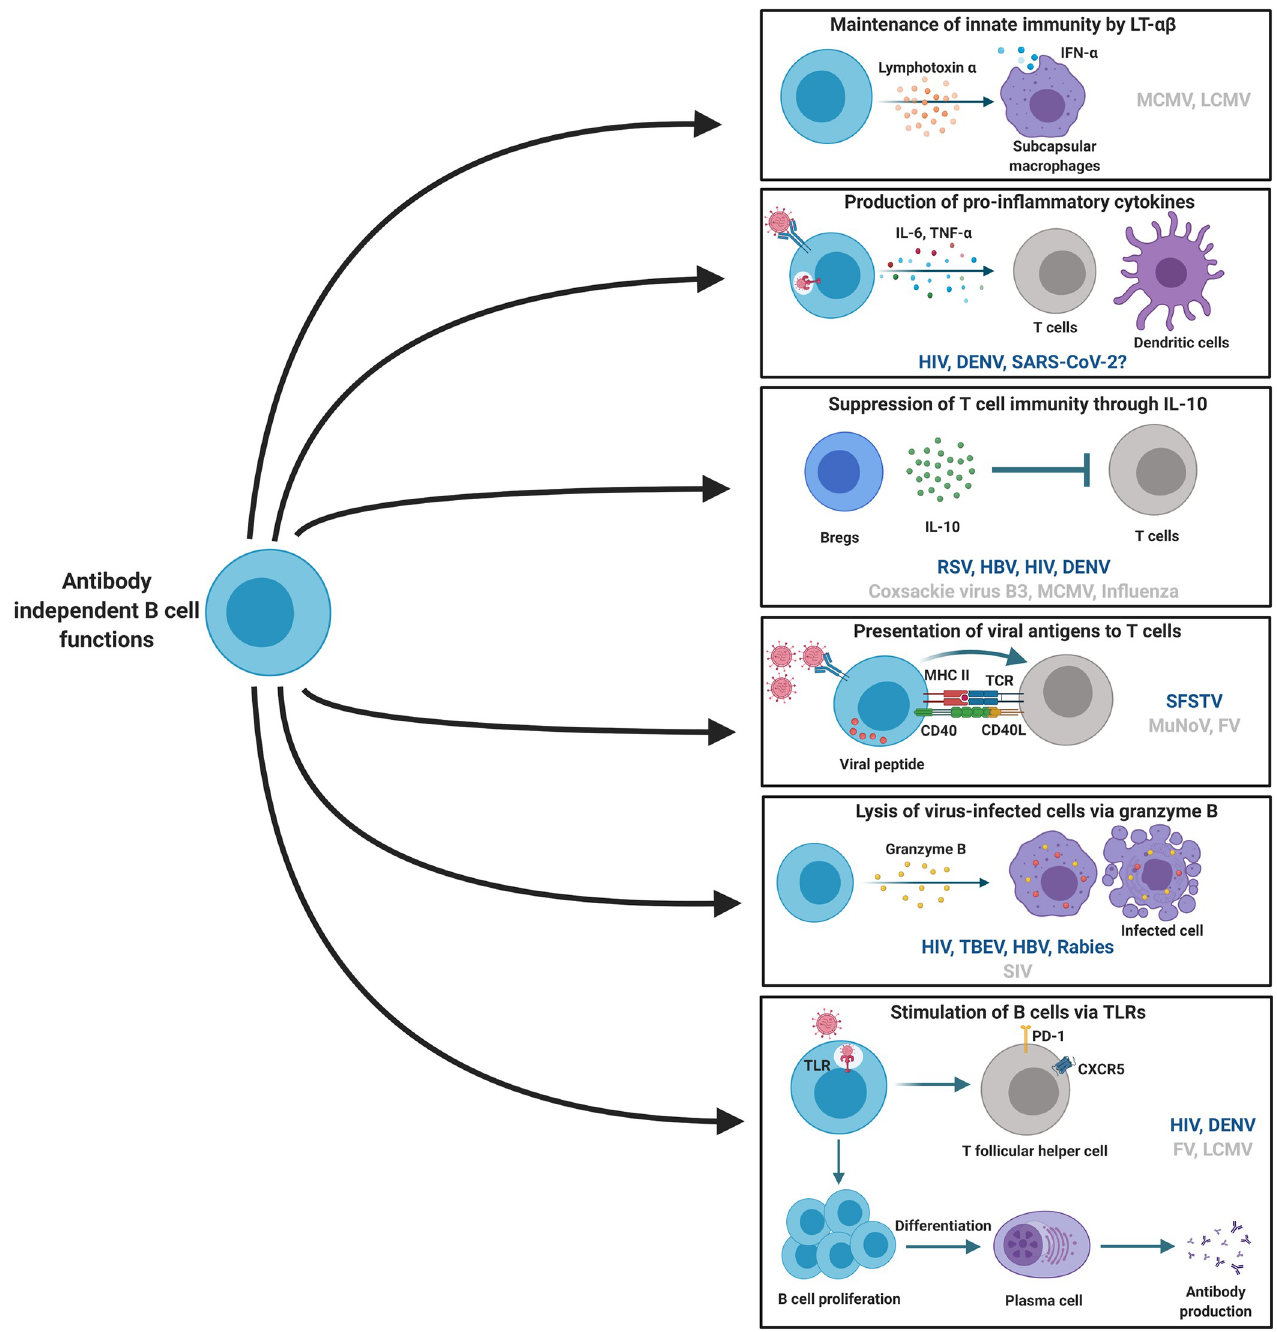
Fig 2. Summary of antibody-independent B cell functions in viral infections. B cells influence immune response to viral infections through production of pro-inflammatory and regulatory cytokines. B cells produce other effector molecules such as cytotoxic GrB and LT- α , which mediate various immune functions. Granzyme B (GrB + ) B cells may contribute to apoptosis of virus-infected cells. B cells produce LT- α , which enhances type I interferon production in myeloid cells. B cells act as professional APCs by presenting viral peptides via MHC II to CD4 + T cells. Stimulation of B cells via TLRs induces downstream signaling resulting in production of antibodies. Created with BioRender.com. APC AU : AnabbreviationlisthasbeencompiledforthoseusedinFig 2 : Pleaseverifythatallentriesarecorrect : , antigen-presenting cell; GrB, granzyme B; DENV, dengue virus; FV, Friend virus; HBV, hepatitis B virus; LCMV, lymphocytic choriomeningitis virus; LT- α , lymphotoxin- α ; MCMV, murine cytomegalovirus; MHC II, major histocompatibility complex class II; MuNoV, murine norovirus; RSV, respiratory syncytial virus; SARS-CoV-2, severe acute respiratory syndrome coronavirus 2; SFSTV, severe fever with thrombocytopenia syndrome virus; SIV, simian immunodeficiency virus; TBEV, tick-borne encephalitis virus; TCR, T cell receptorTLR, Toll-like